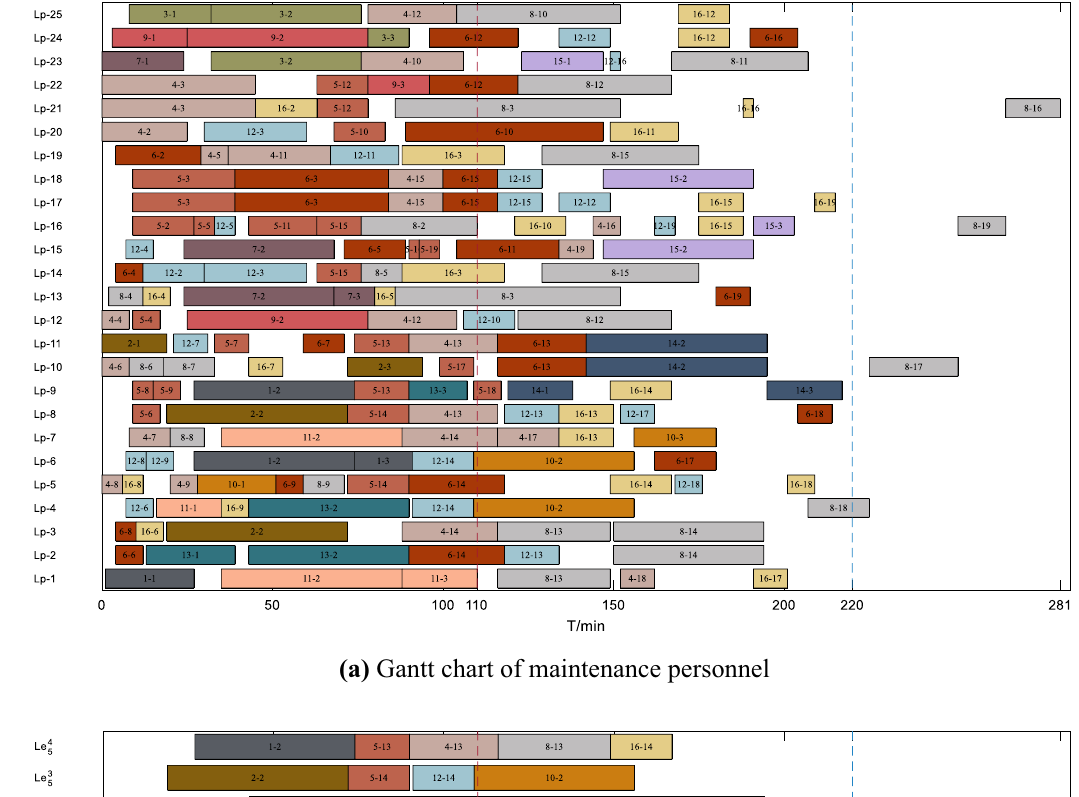
to analyze reactive scheduling decisions and design three groups of operational delay events based on the time